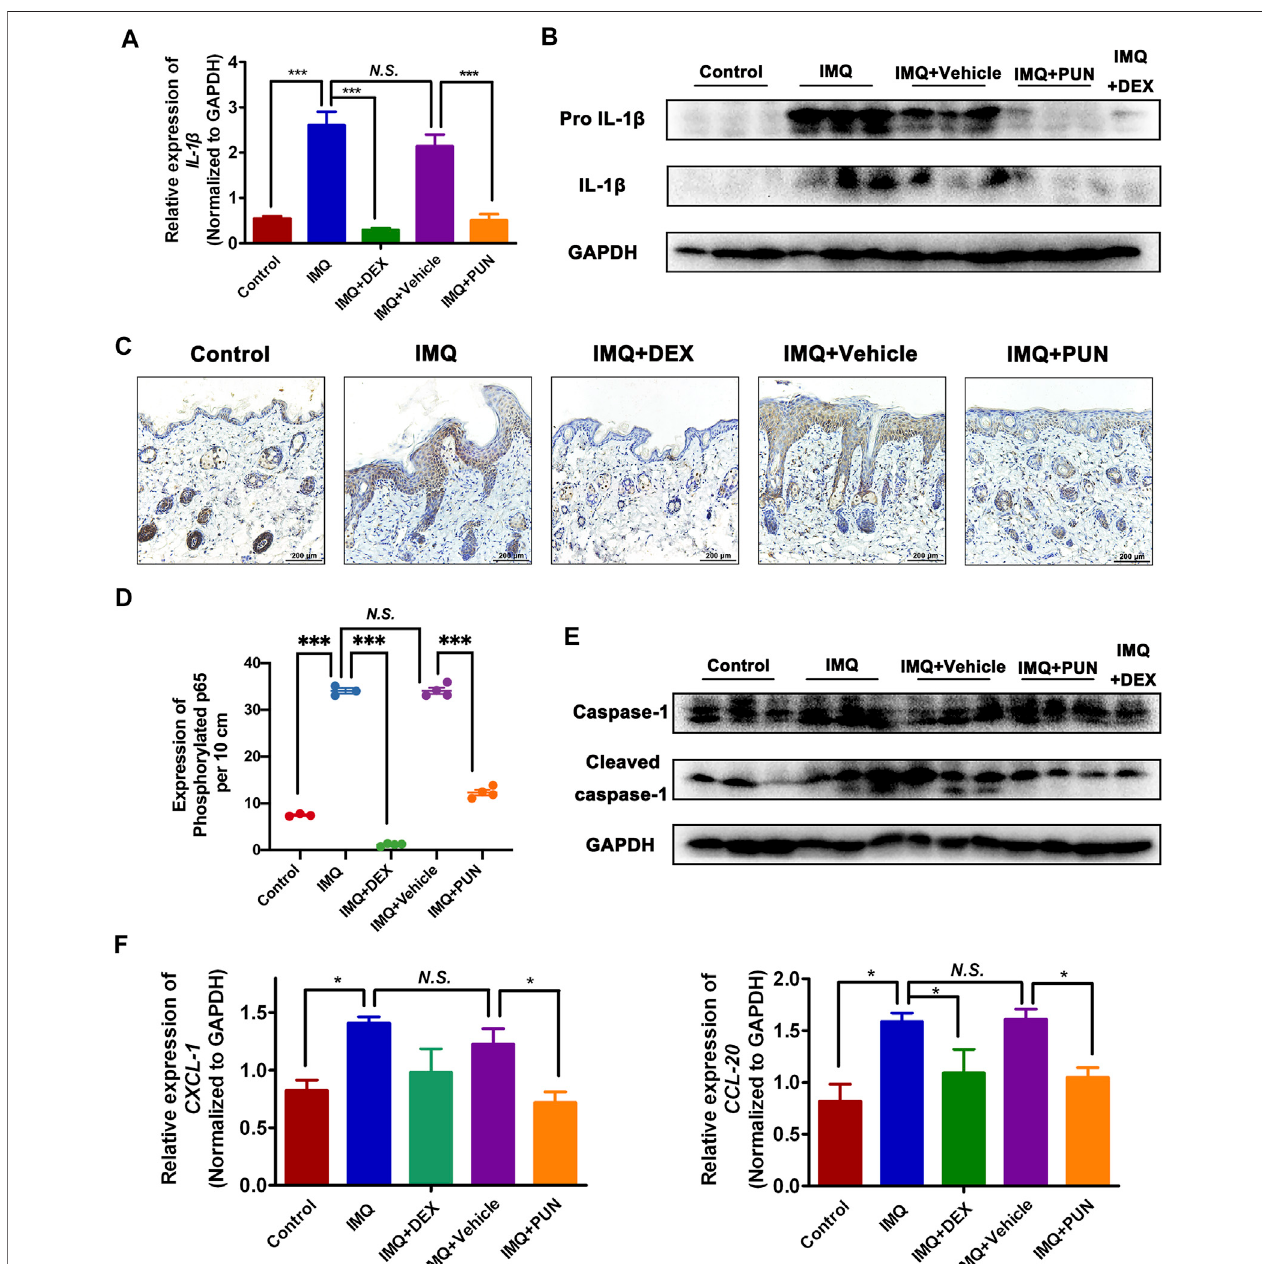
FIGURE3| PunicalaginattenuatestheenhancementofIL-1 β bysuppressingNF- κ Bactivationandcaspase-1expression invivo . (A) TherelativemRNAlevelof IL- 1 β in Control/IMQ/IMQ + DEX/IMQ + Vehicle/IMQ + PUN groups. (B) The protein expression of IL-1 β in Control/IMQ/IMQ + DEX/IMQ + Vehicle/IMQ + PUN groups. (C, D) Immunohistochemicalstainingandstatisticalanalysisofphosphorylatedp65(Ser536)inskinsectionsderivedfromtheControl/IMQ/IMQ+DEX/IMQ+Vehicle/IMQ+ PUNgroup.Scalebars:200 μ m. (E) Theexpressionofcleavedandtotalcaspase-1inskinsectionsderivedfromtheControl/IMQ/IMQ+DEX/IMQ+Vehicle/IMQ+ PUNgroup. (F) TherelativemRNAlevelof CXCL-1 (left)and CCL-20 (right)intheskinlesionsfromControl/IMQ/IMQ+DEX/IMQ+Vehicle/IMQ+PUNgroups.* p < 0.05, *** p < 0.001, N.S. , non-signi fi cant. One-way ANOVA with Student-Newman-Keuls method for (A, D, F) . Data represent the mean ± S.E.M.